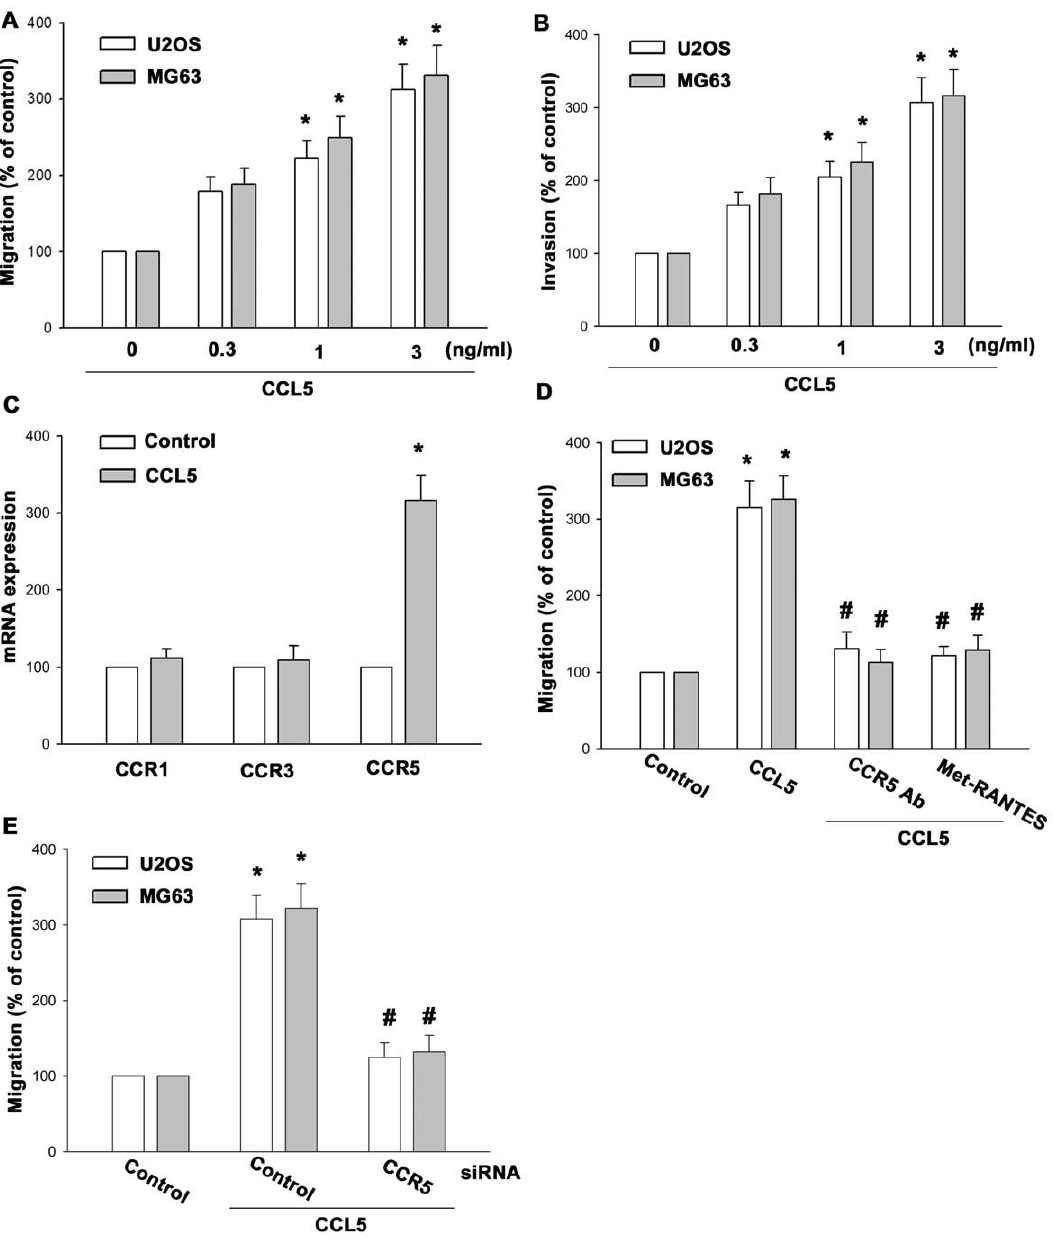
Figure 1. CCL5 and CCR5 interaction increased migration of human osteosarcoma cells. (A&B) MG63 or U20S cells were incubated with various concentrations of CCL5, and in vitro migration and invasion activity measured with the Transwell after 24 h. (C) MG63 cells were incubated with CCL5 (3 ng/ml) for 24 h, and the mRNA expression of CCR1, CCR3 and CCR5 was examined by qPCR. MG63 or U20S cells were pretreated for 30 min with CCR5 Ab, Met-RANTES (D) or transfected with CCR5 siRNA (E) for 24 h. Then they were followed by stimulation with CCL5, and in vitro migration was measured with the Transwell after 24 h. Results of five independent experiments performed are expressed. Results are expressed as the mean 6 S.E. *, p , 0.05 compared with control; # , p , 0.05 compared with CCL5-treated